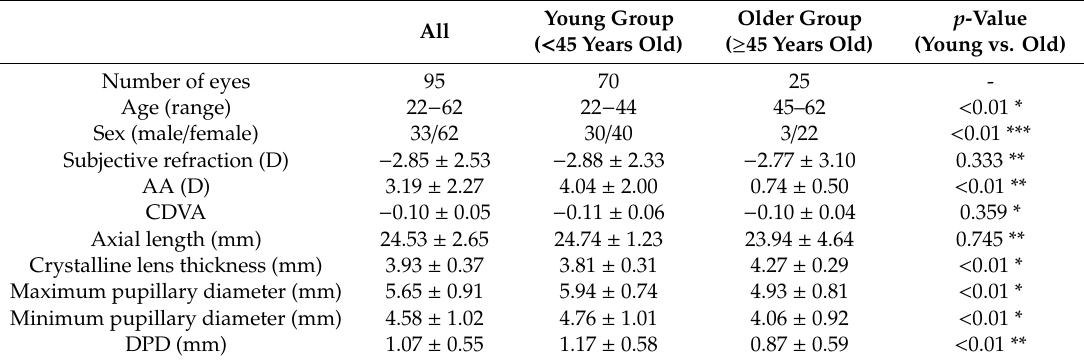
Table 1. Participant profiles and results of ocular examinations.